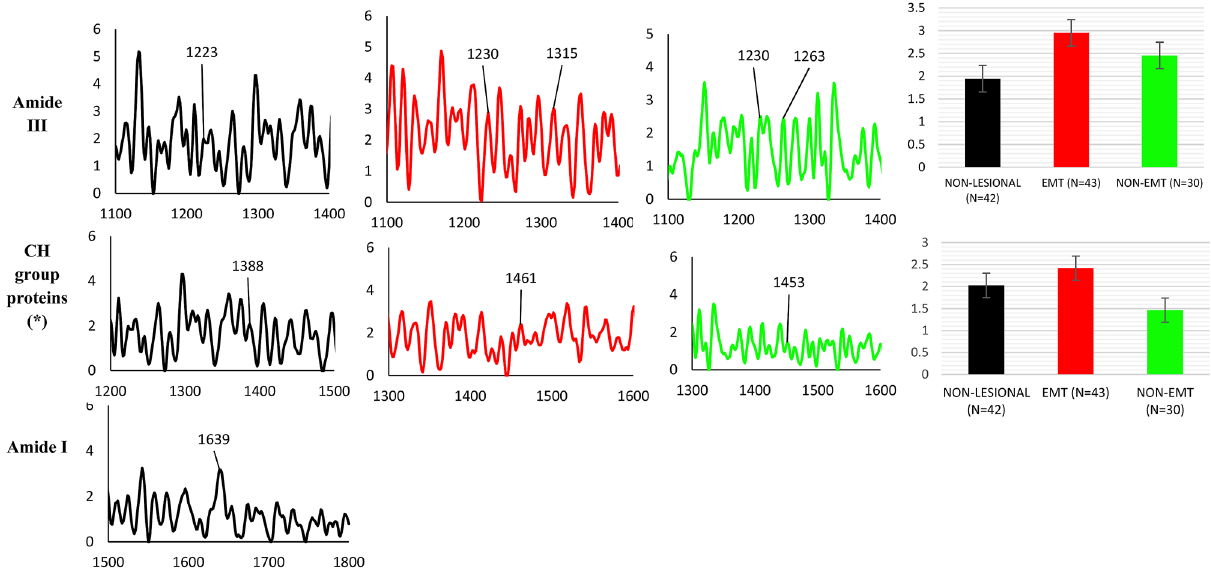
Figure 6. Summary of protein vibrational bands observed for dewaxed samples (Group 1) of non-lesional, EMT and non-EMT breast cancer tissue. For each case, the x-axis represents the wavenumber while the y-axis represents the intensity. The black colour represents the non-lesional tissues, while red represents EMT tissues and green represents non-EMT tissues. Comparison of relative intensity of protein Raman bands for dewaxed samples of non-lesional, EMT and non-EMT breast tissue is depicted in the bar charts. Each column represents the average of spectra for each type of tissue. The value of N represents the number of Raman spectra acquired for each sample, shown within the brackets. The error bar represents standard deviation. Note: the x-axis represents the tissue type and y-axis is Raman intensity. (*) denotes a statistically significant difference between the groups reported by the ANOVA